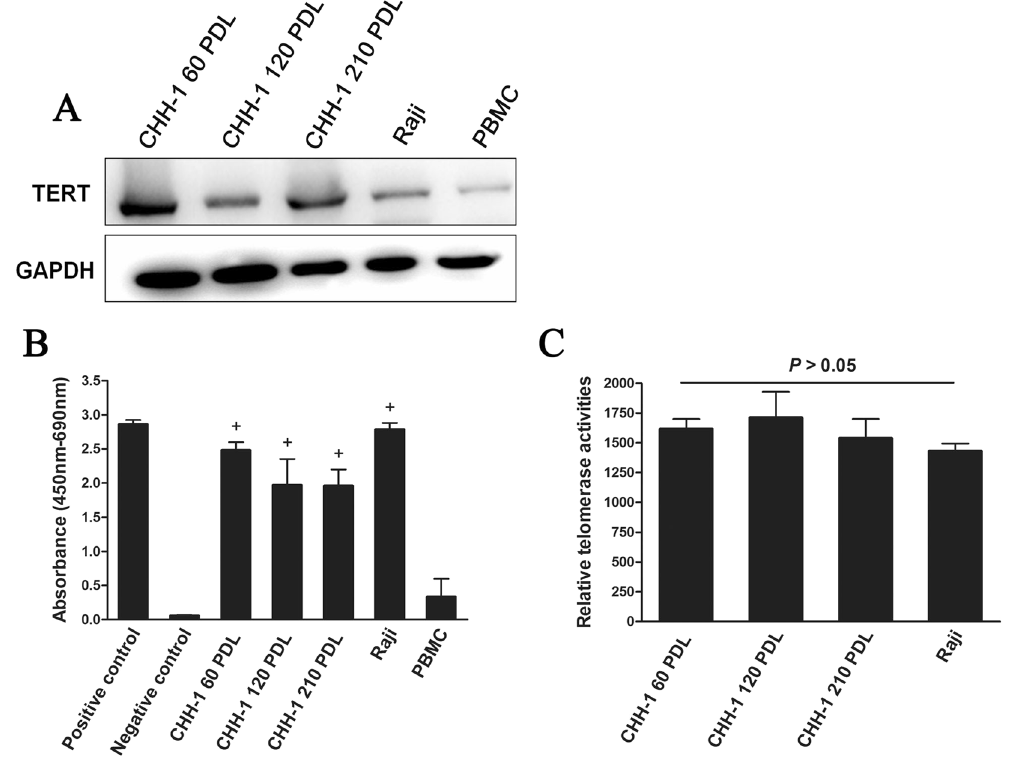
Figure 5. Telomerase activity of CHH-1 cells. ( A ) TERT expression can be detected expression in different PDLs of CHH-1 cells by Western blot. GAPDH is used as an internal control. TRAP-ELISA analysis demonstrates that ( B ) the telomerase of CHH-1 cells is activated, and ( C ) the relative telomerase activity of different PDLs CHH-1 cells is insignificantly high as compared with Raji cells. + Means telomerase of cells is activated. Raji cell line is used as a positive control. PBMCs from a normal person are used as a negative control. Values are given as mean ± SD of three independent